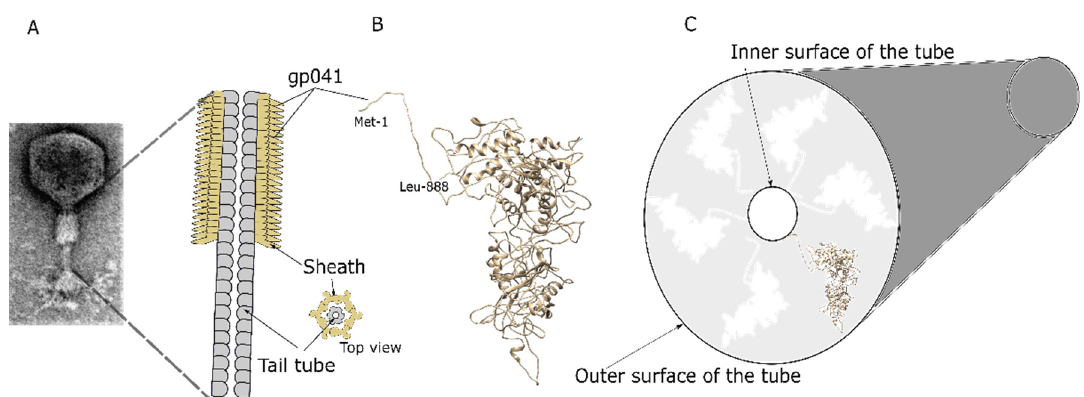
Figure 2. Schematic representation of structures formed by protein 041. TEM image of bacteriophage vB_KleM-RaK2 and schematic view of its contracted sheath ( A ); a model of 041 protein generated by the PS 2 server ( B ); the N- and C-terminal amino acids are indicated; the possible tube scheme based on the known structures of the tail sheaths ( C ).